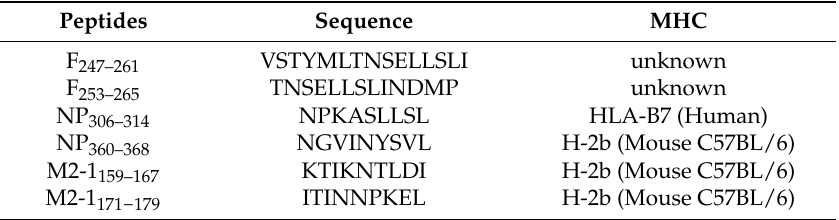
Table 1. List of peptides for RSV-F, NP, and